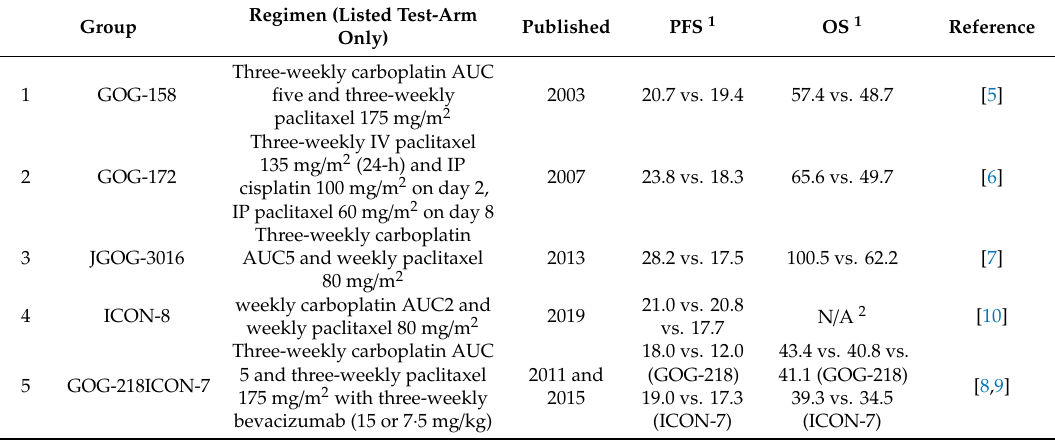
Table 2. Summary of milestones of adjuvant chemotherapy based on prior clinical